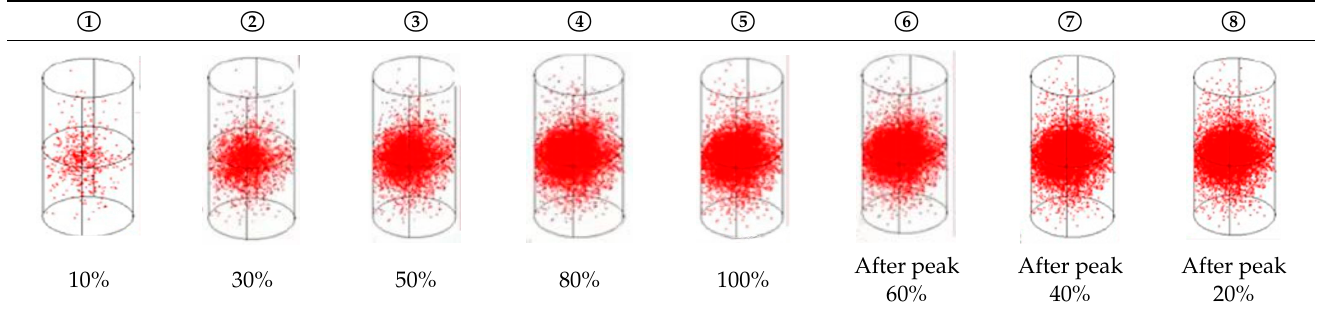
Figure 16. Stress-strain curve and space-time evolution law of acoustic emission [70]. Table 10. Evolution law of acoustic emission at different loading stages.